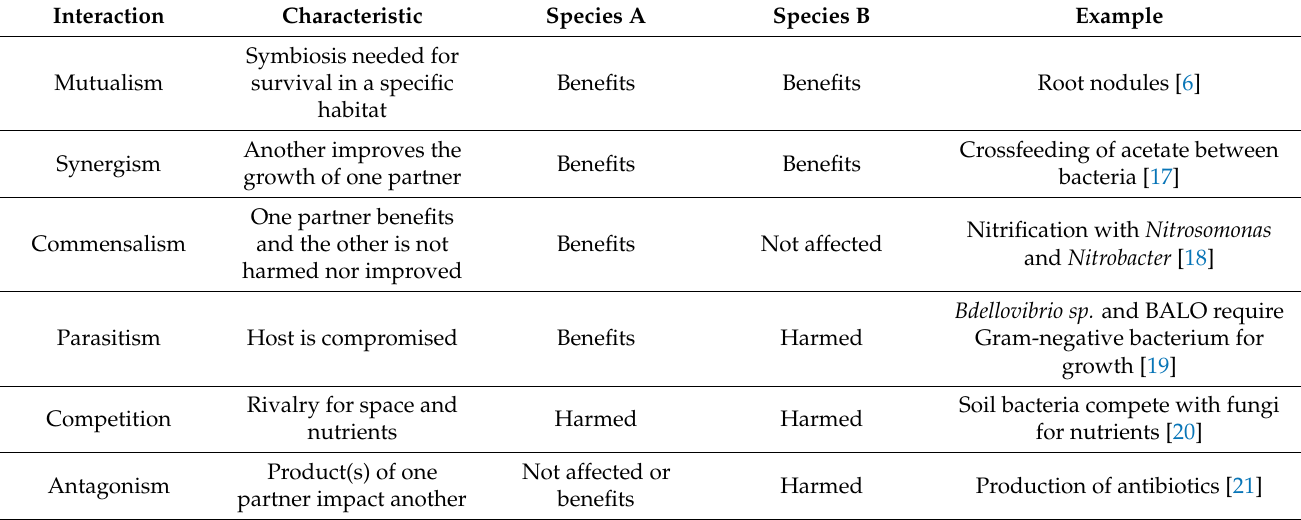
Table 1. Types of microbial interactions adapted from